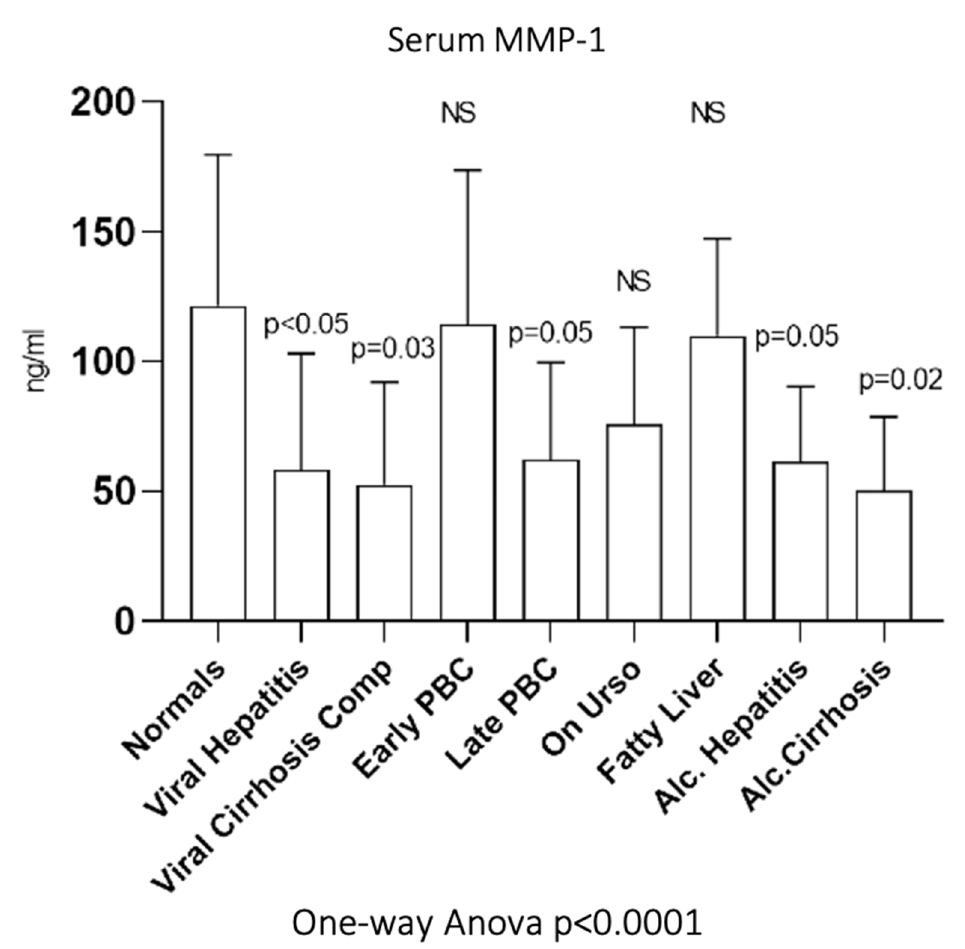
Figure 6. Serum MMP-1 in all studied groups. Mean and standard deviation are presented.